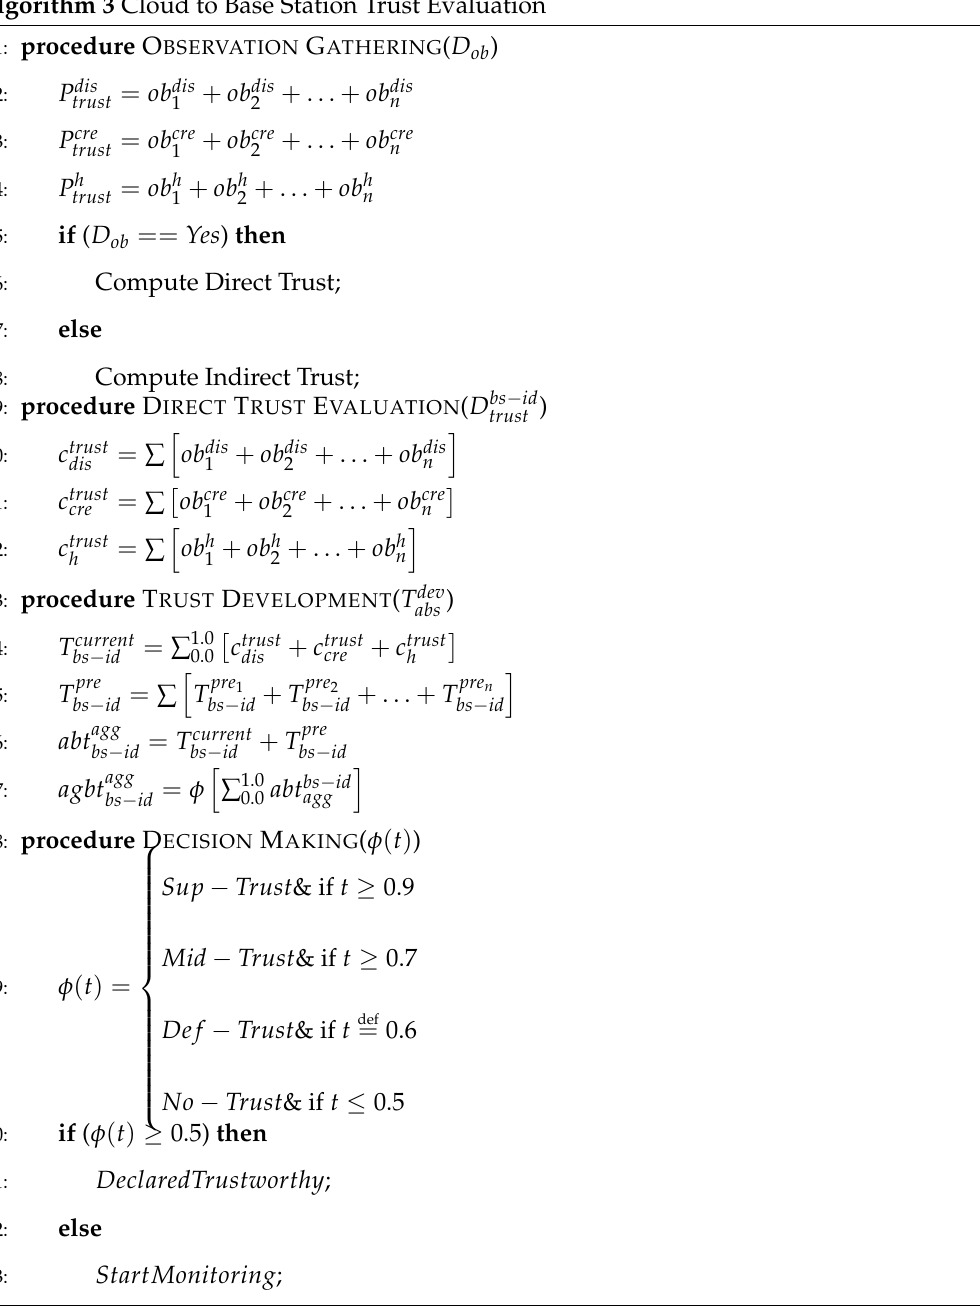
Algorithm 3 Cloud to Base Station Trust